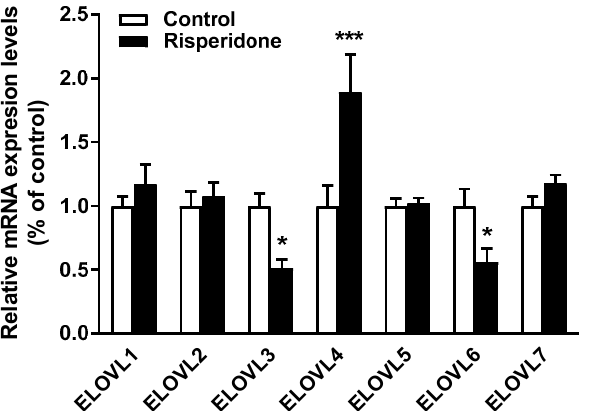
Figure 3. Effects of risperidone on the gene expression of fatty acid elongases (ELOVLs). THP-1 cells were treated or not with risperidone for 72 h. Cells were collected, total mRNA was extracted, and mRNA expression was quantified by qRT-PCR. Expression levels were normalized to RPLP0 and are shown as percentages of control. Data are means ± SEMs of five independent experiments performed in triplicate. Statistical comparisons shown are risperidone vs. control (* p < 0.05 and *** p <